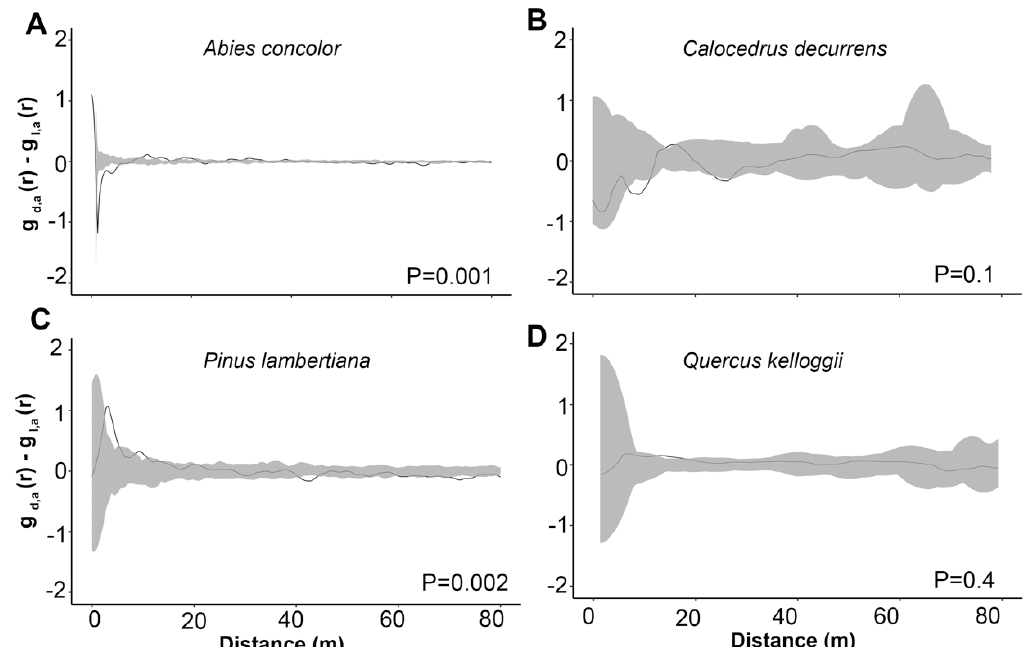
Figure 7. Spatial pattern of the conspecific neighborhood around dead trees (survived the fire but died in 2015–2019) and live trees (survived throughout the time period 2015–2019) in Abies concolor ( A ), Calocedrus decurrens ( B ), Pinus lambertiana ( C ), and Quercus kelloggii ( D ) in the Yosemite Forest Dynamics Plot. The g(r) function indicates the pair correlation function, r is distance, and subscripts l, d, and a indicate live, dead, and all trees. Values above the simulation envelopes imply that live trees had more crowded conspecific neighborhoods than dead trees (conspecific negative density dependence). p -values are based on goodness-of-fit test implemented at distances of 0–4 m. The gray areas represent the simulation envelopes under the random labelling null model.